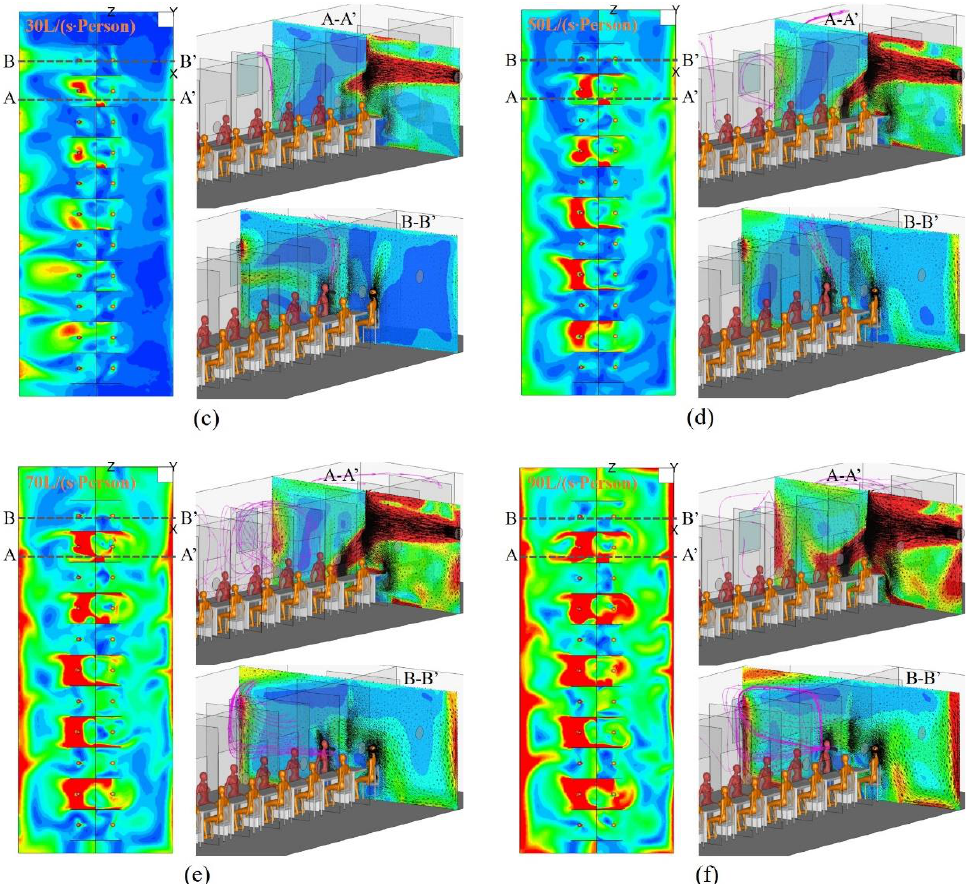
Figure 5. Airflow patterns at the planes of y = 1.1 m, x = 1.09 m, and x = 2.25 m under the MSFV with different ventilation rates: ( a ) 10 L/(s∙Person); ( b ) 20 L/(s∙Person); ( c ) 30 L/(s∙Person); ( d ) 50 L/(s∙Person); ( e ) 70 L/(s∙Person); ( f ) 90 L/(s∙Person).